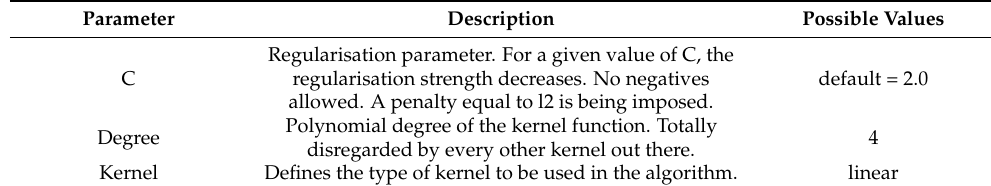
Figure 14. Performance of GA-SVM on Heart Disease. The selected best GA-SVM parameters are shown in Table 4. Table 4. Selected best GA-SVM